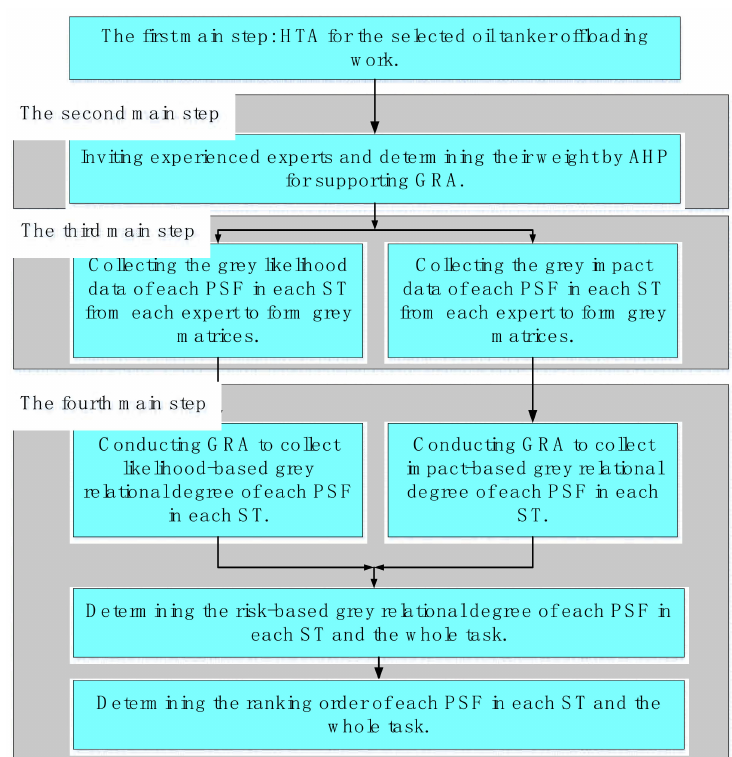
Figure 4. Research procedure of this study.